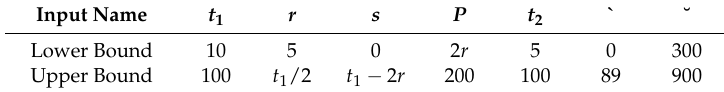
Table 1. Lower (LB) and upper (UB) bounds of the input data for random data generation.